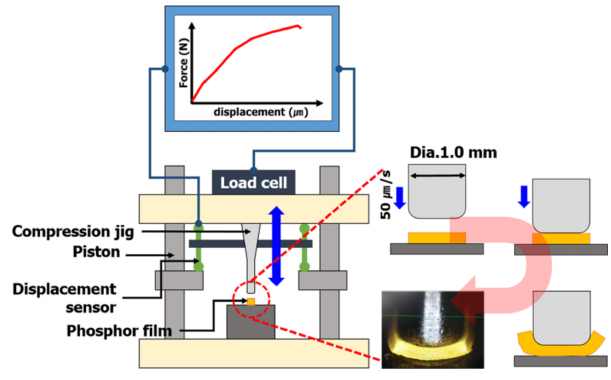
Figure 3. Compression breaking strength measurement diagram.